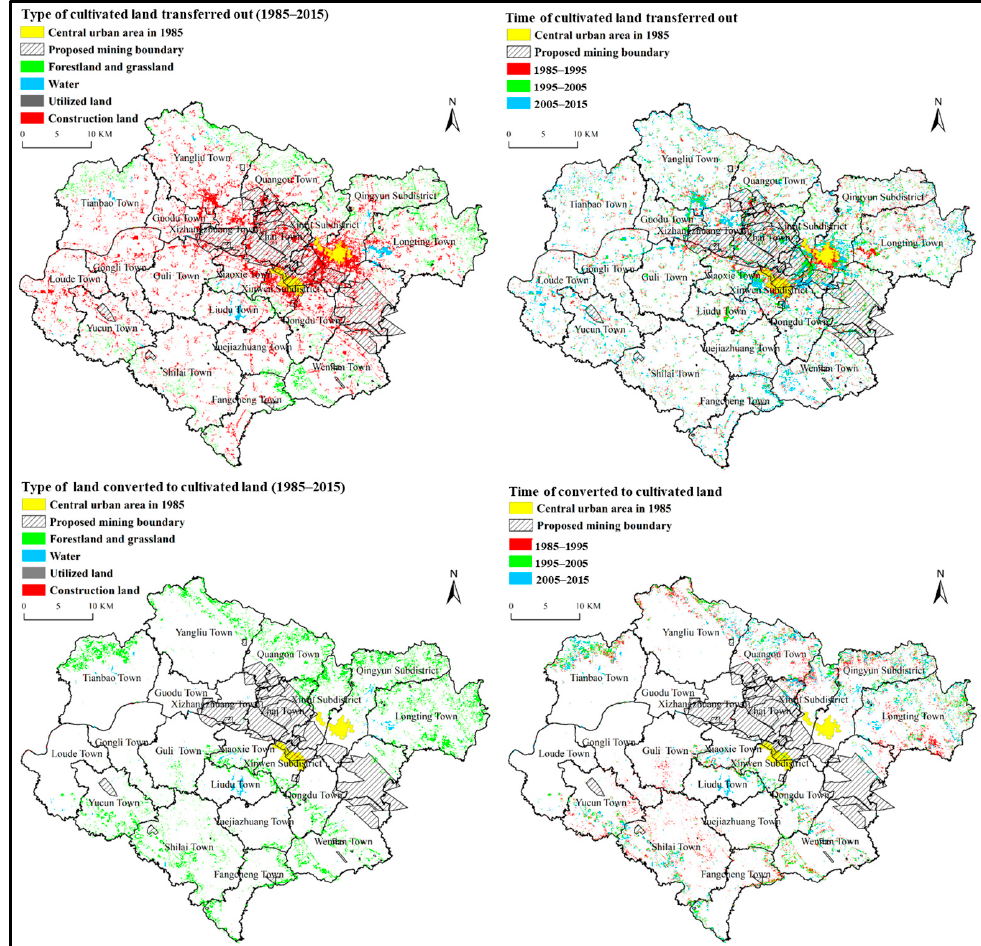
Figure A3. Types and time of changes in cultivated land.